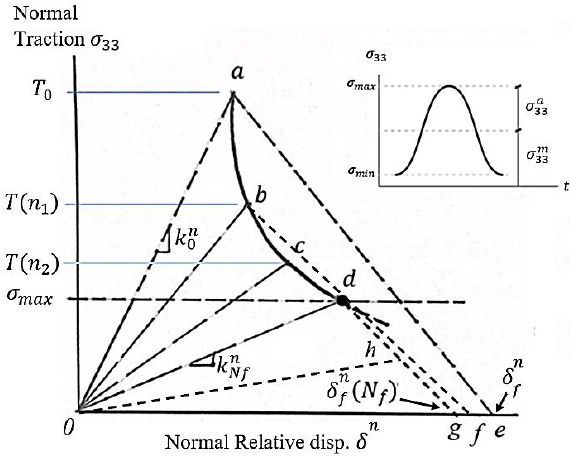
Figure 2 . Interlaminar fatigue damage model illustrated for the mode I crack loading